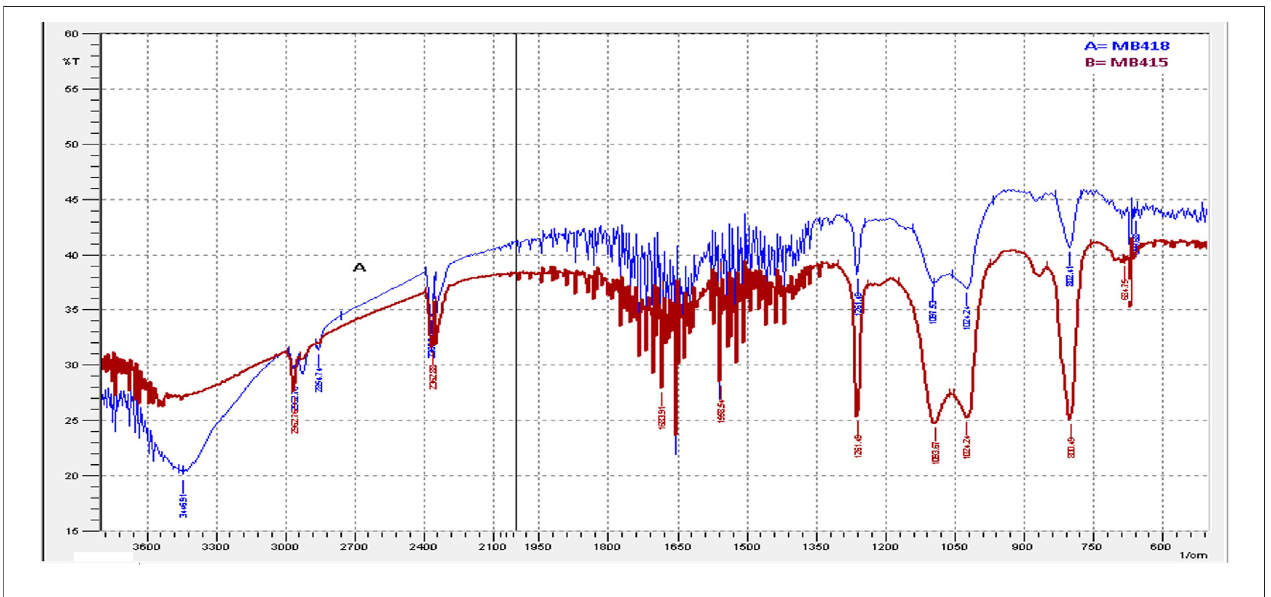
FIGURE 1 | FTIR spectra of extracted biosurfactants.